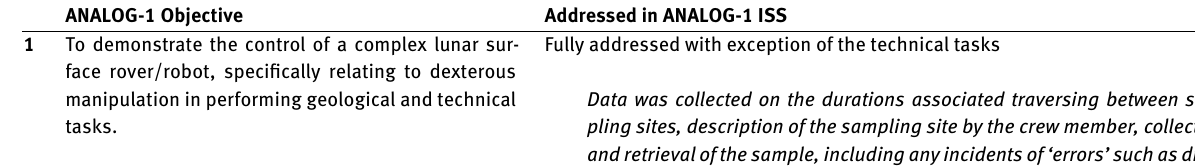
Table 1. Summary of ANALOG-1